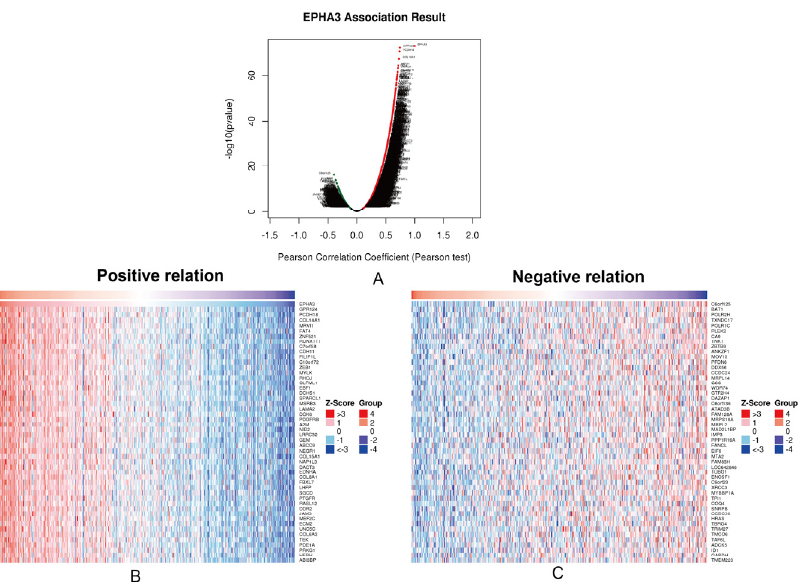
Figure 6. EPHA3 and co-expressed gene analysis within BLCA. ( A ) Volcano plot showing co-expressed genes with a positive and negative relation to EPHA3 within BLCA. ( B ) Fifty most signifi- cant genes with positive and ( C ) negative relation to EPHA3.